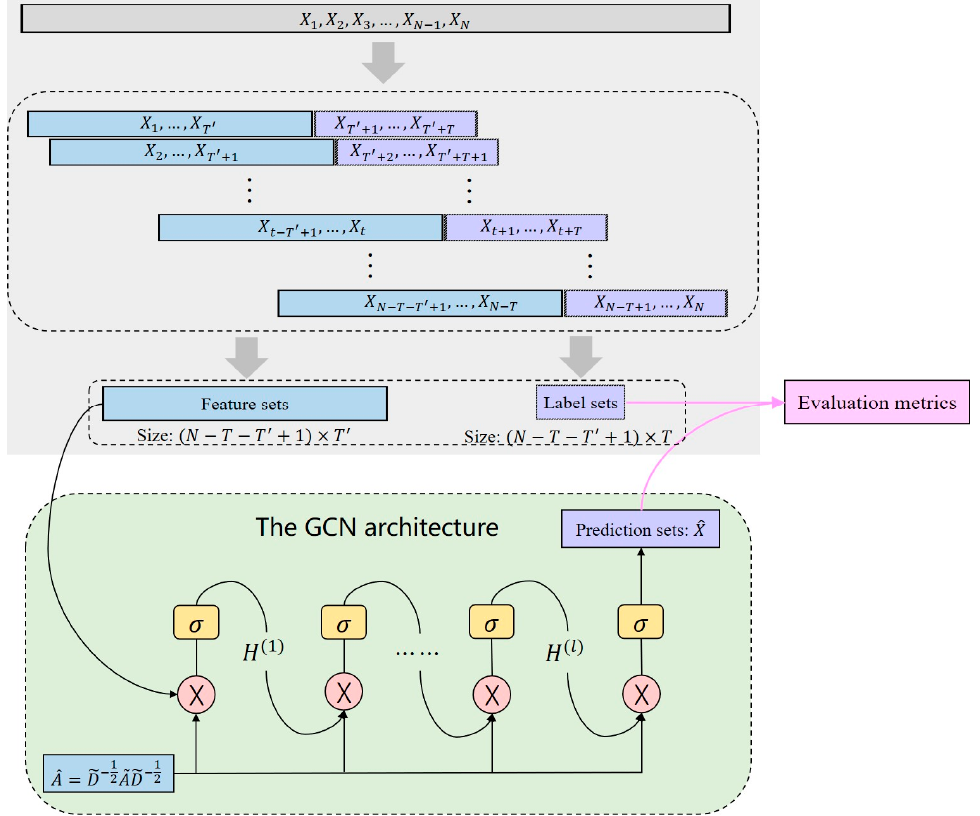
Figure 3. The framework of the GCN model for pedestrian flow prediction.